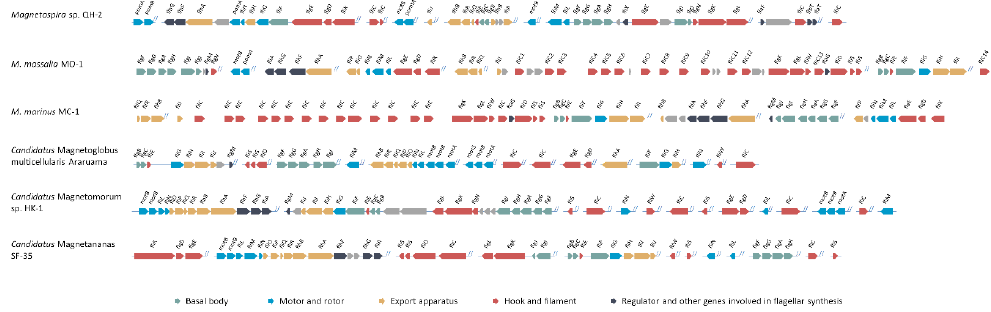
Figure 2. Organization of flagella genes in model magnetotactic bacteria. The data are derived from genomic data of amphitrichously flagellated Magnetospira sp. QH-2 [10], bilophotrichously flagellated M. massalia strain MO-1 [18] and M. marinus strain MC-1 [19], peritrichous flagellated spherical magnetoglobules Ca. M. multicellularis Araruama [20], Ca. Magnetomorum strain HK-1 [21], and ellipsoidal magnetoglobules Ca. Magnetananas updated from the incomplete genome sequence [22]. Separated localization of the gene clusters is marked by double slashes. Arrows show the genes and their transcriptional direction; their lengths are proportional to the size of the genes.